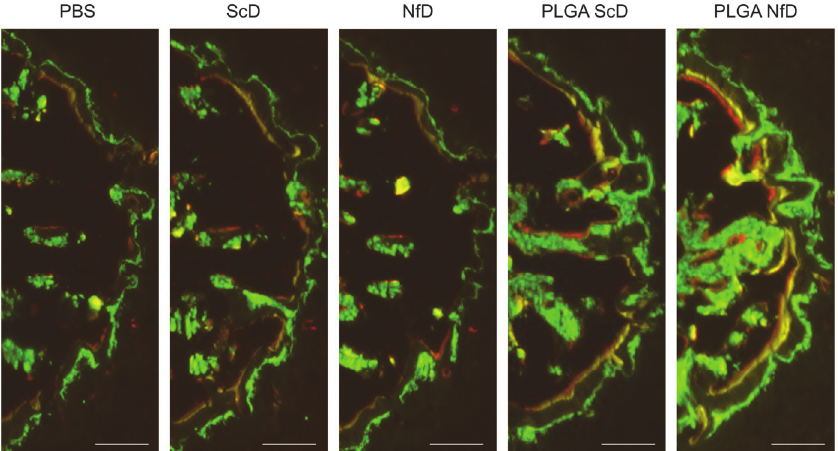
Figure 3. Assessment of dynamic fluorescent bone labeling of tooth-extraction sockets. Representative fluorescent images of the mesial portion of the M1 mesial socket labeled with fluorescent reagents targeting calcein (day 6), demeclocycline hydrochloride (day 15), and alizarin complexone (day 24) after tooth extraction. Magnification: 40×. Scale bar = 100 µm. Abbreviations: NfD, naked NF- κ B decoy; NF- κ B, nuclear factor-kappa B; ODN, oligodeoxynucleotide; PBS, phosphate-buffered saline; PLGA, poly(lactic-co-glycolic acid); PLGA-NfD, NF- κ B decoy ODN-loaded PLGA nanosphere; PLGA-ScD, scrambled decoy ODN-loaded PLGA nanosphere; ScD, naked scrambled